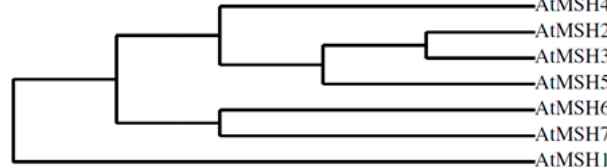
Figure 1. Cladogramphylogenetic tree representing the evolutionary relationships of AtMSH proteins.